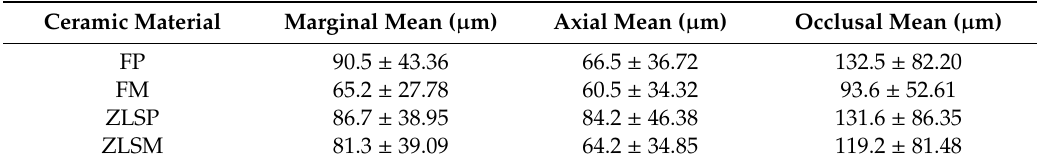
Table 4. Mean values ( µ m) and standard deviations (SD) of the tested materials before cementing and